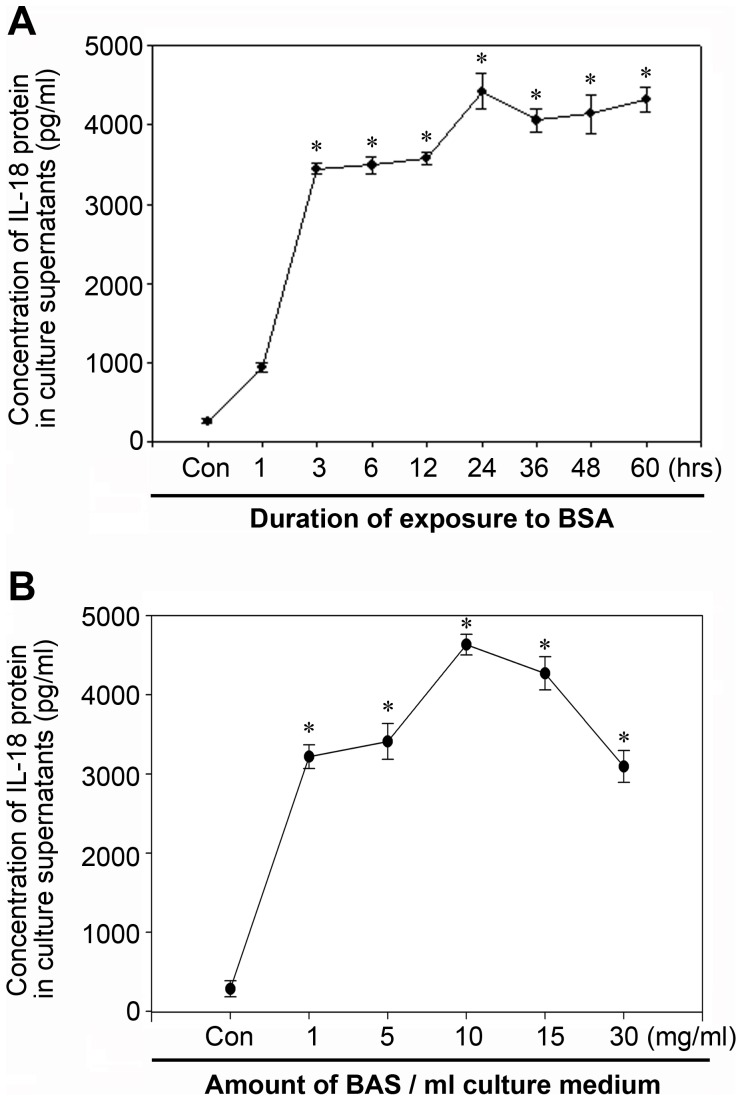
Bovine serum albumin induced up-regulated IL-18 secretion in supernatant of NRK-52E cells.A. Time course of IL-18 secretion in the supernatant of NRK-52E cells. Growth arrested NRK-52E cells were culture in DMEM-F12 containing 5 mg/ml BSA for 1–60 hours. IL-18 secretion in the culture was assayed by ELISA. B. Dose course of IL-18 secretion in the supernatant of NRK-52E cells. IL-18 secretion was dected as above. Data are presented as mean±SEM of three independent experiments. *P<0.05 vs. control.